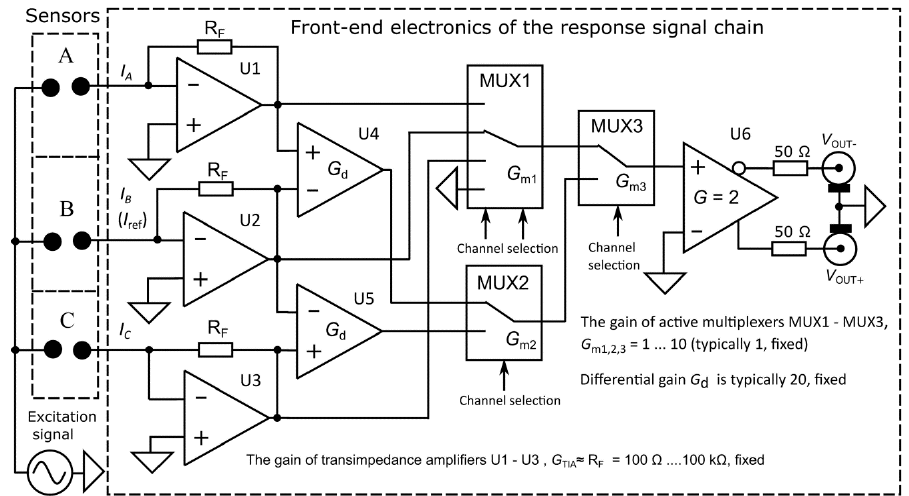
Figure 3. Structure of the front-end electronics of the response module. The signal of channel B is used for acquiring the impedance differences with sensors A and C. The signal differences from the outputs of U1 and U2, and, U3 and U2, are amplified by amplifiers Gd. Both direct and amplified differential signals of all channels are forwarded to the output via high-speed multiplexers MUX1 and MUX2, allowing calculation of actual values of amplified differences of impedances. The reference signal of channel B may be obtained from a sensor connected to it, or from a reference signal source.